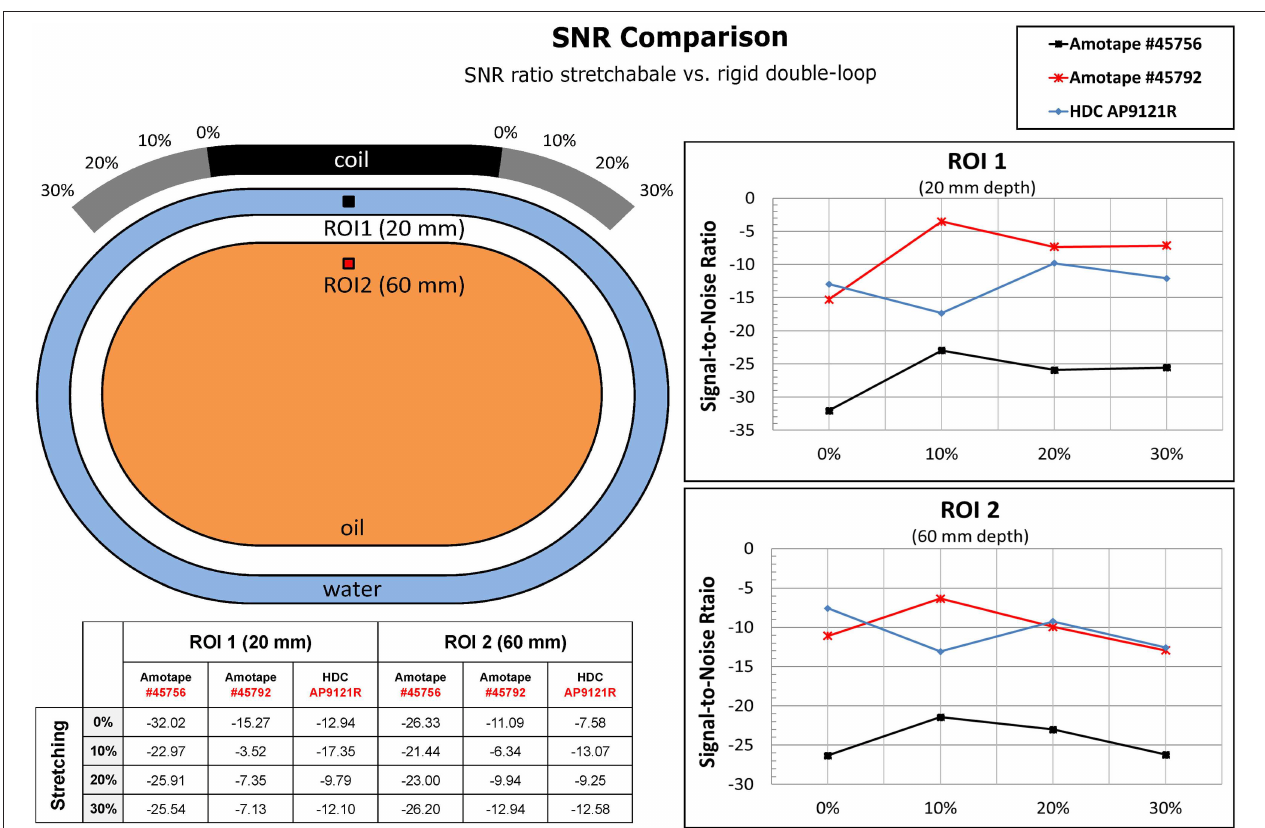
FIGURE 6 | The Signal-to-Noise ratio (SNR) of the three different stretchable materials, compared to each other. The SNR was measured in a region of interest (ROI of 5 5 pixel) at 20 and 60mm depth from the coil. The SNR losses were acquired from the SNR maps, calculated with the maximum available method, the stretchable × double loop in the different stretching states compared with the SNR maps of the corresponding reference double loop. The torso-shaped phantom consists of a main body (blue) filled with per 1,000mL Bayol-oil and 0.011g MACROLEX blue and an outer compartment (clear) with per 1,000g H 2 O dist.: 1.25g NiSO 4 5g